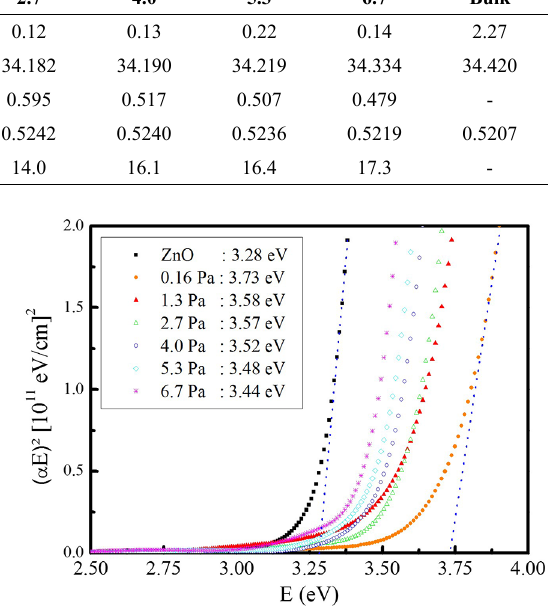
Table 3. Structural results obtained by XRD analysis of the AZO films at different sputtering pressures. The bulk value is tabulated by JCPDS 36-1451 (International Centre for Diffraction Data, 1990) for the hexagonal structure ZnO. Pressure (Pa)